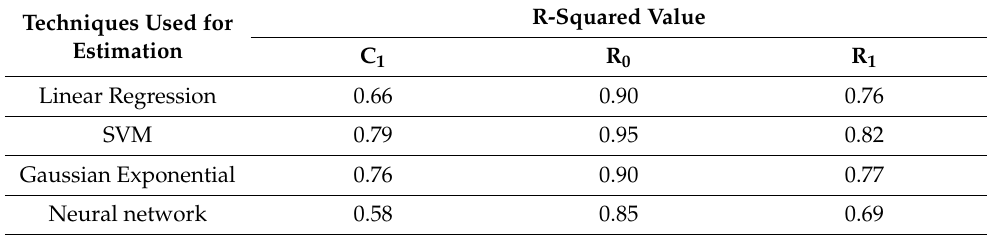
Table 4. Cell parameter estimation using different techniques. Techniques Used